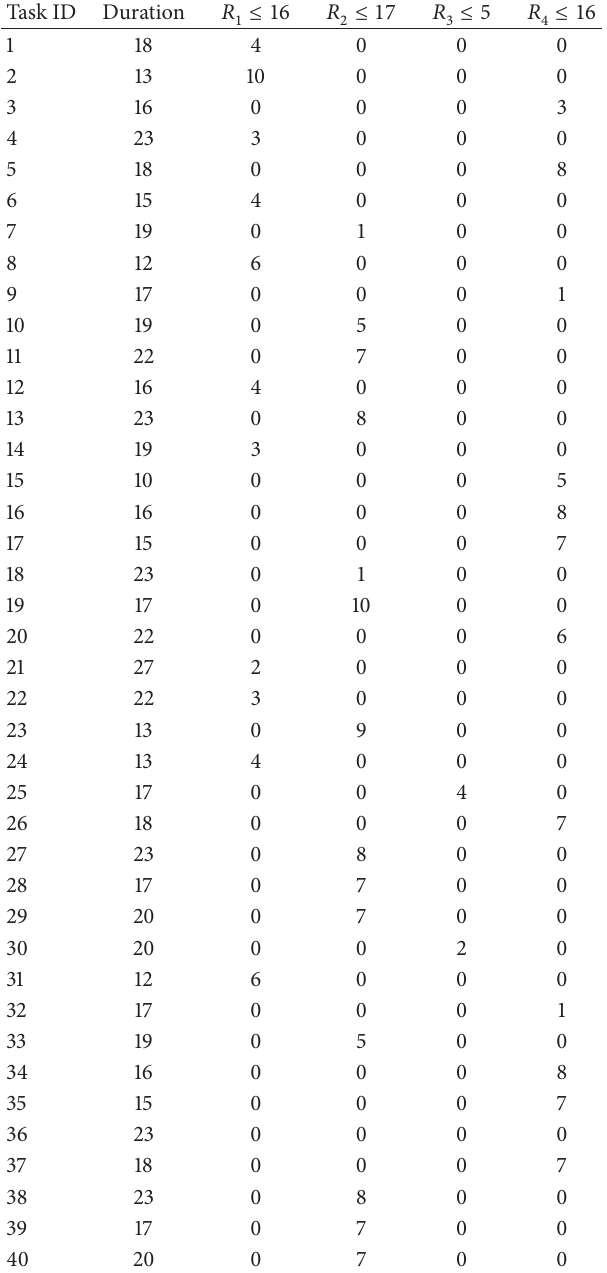
Table 1: Properties of